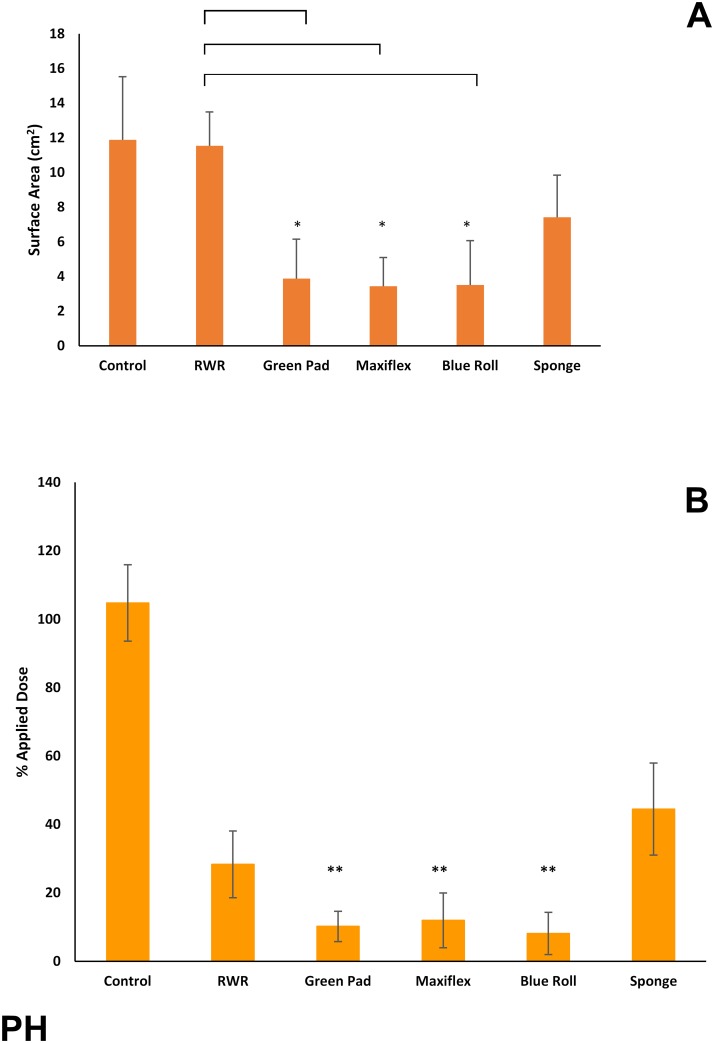
(A) Skin surface spreading and (B) recovery of 14C-phorate (expressed as percentage of applied dose) remaining on, within or penetrated through dermatomed pig skin following decontamination (after 15 minutes) with test products (green incontinence pads, Maxiflex wound dressing, absorbent tissue paper (blue roll) or polyurethane sponge) or the rinse-wipe-rinse method (RWR).All values are mean ± standard deviation of n = 6 replicates. Asterisks indicate significant differences between treated and untreated (control) skin: *p<0.05; **p<0.01; ***p<0.001.